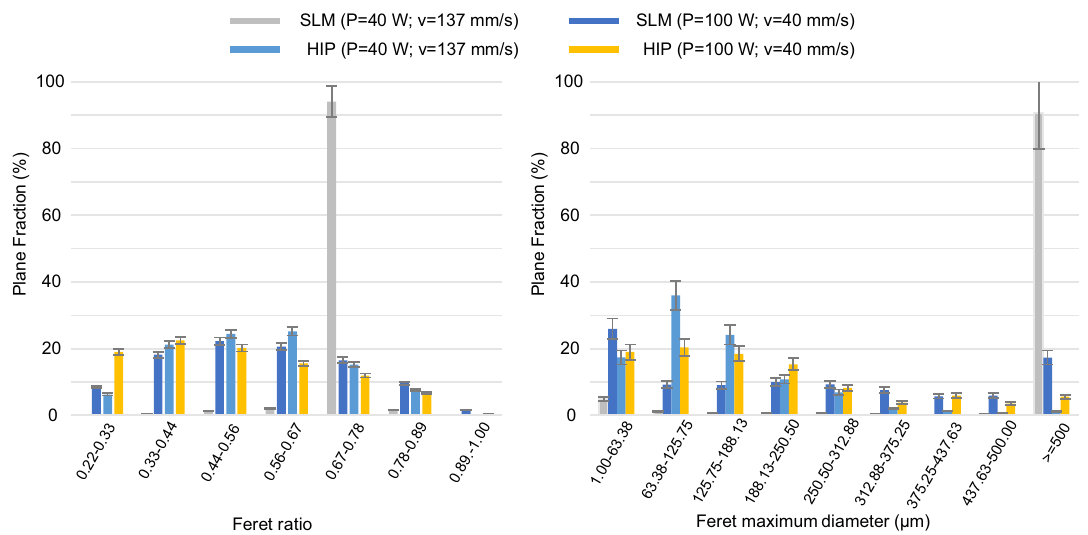
Figure 9. Distribution of sizes and shapes of pores for low and high energy densities before and after the HIP process.